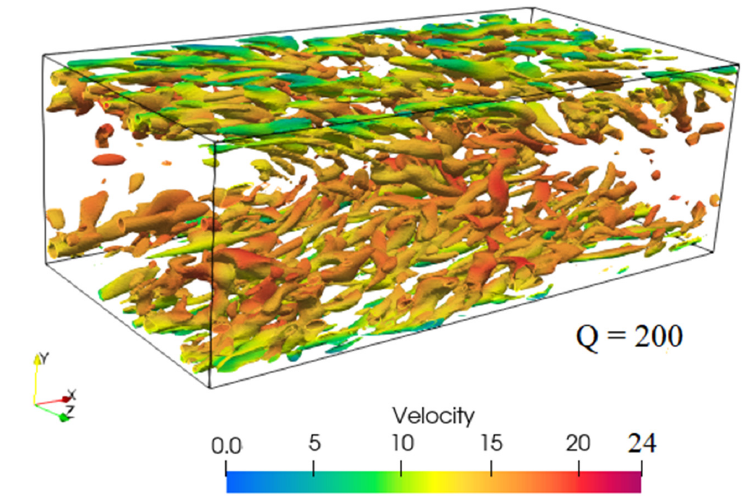
Figure 17. Vortex core isosurface contour of the smooth wall case.